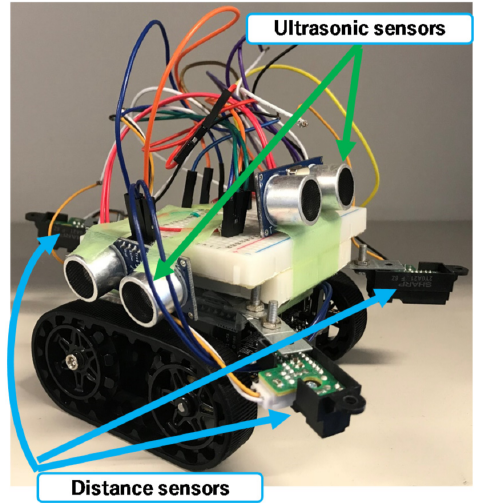
Figure 2. The robot developed to carry out this work.